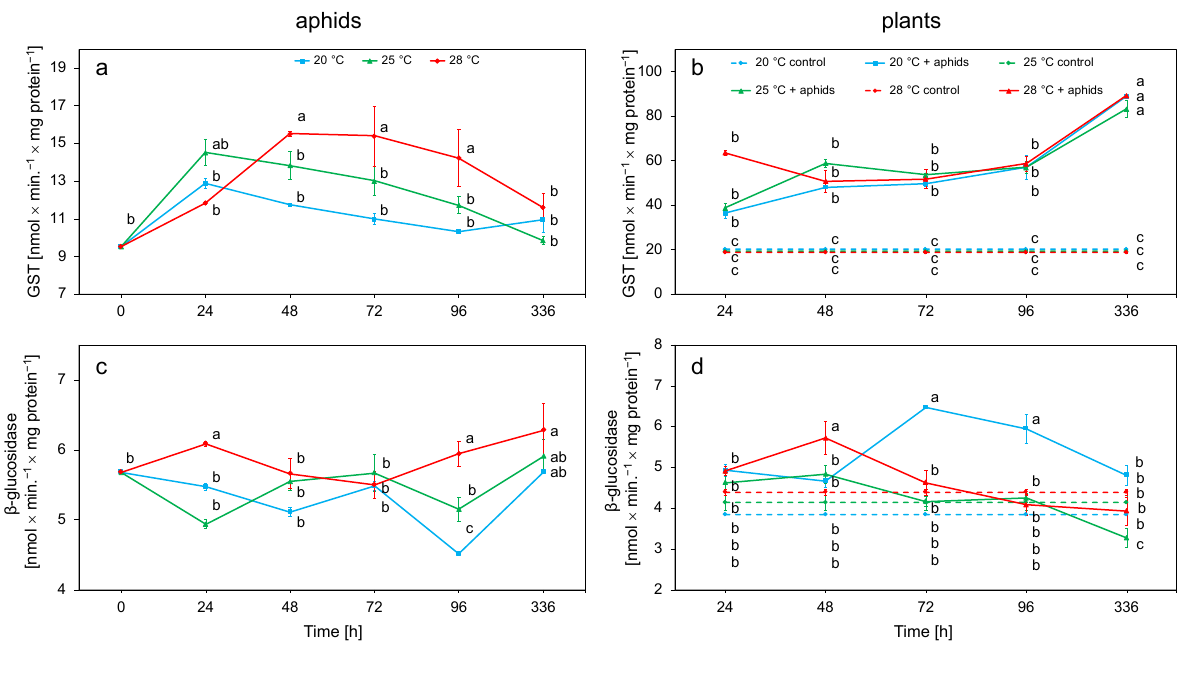
Figure 4. Changes in GST and β -glucosidase activity (means ± SE) in the tissues of Macrosiphum rosae ( a , c ) and Rosa rugosa at different temperatures and during aphid feeding ( b , d ). Values marked with different letters differ significantly at p < 0.05 (Duncan